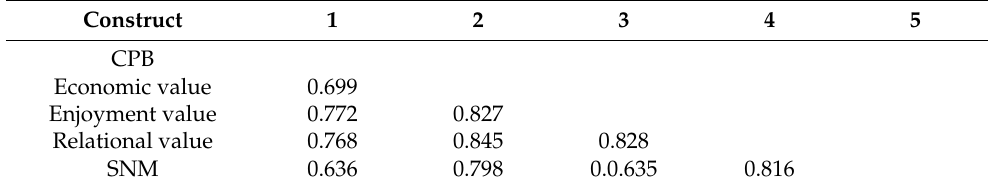
Table 3. Heterotrait-Monotrait Ratio (HTMT).